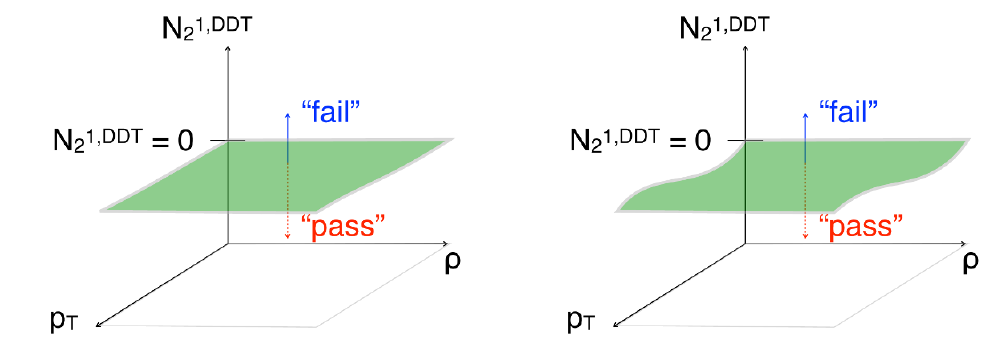
Figure 4 . A schematic of the background estimation method. The pass-to-fail ratio, R ( (cid:26) ( m SD ; p T )), is de(cid:12)ned from the events passing and failing the N 1,DDT p = f N 1,DDT